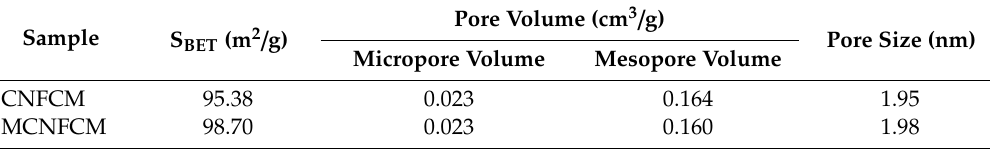
Table 7. N 2 Ads–des analysis of CNFCM and modified